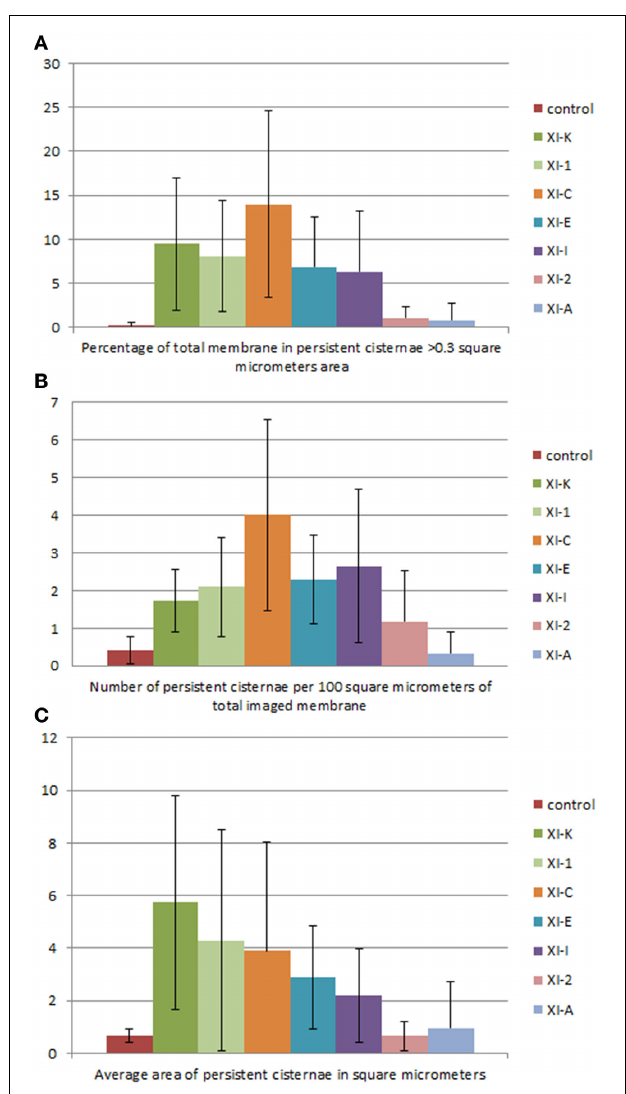
FIGURE 7 | Quantification of the effects of myosin tail domains on persistent ER cisternae. (A) Counts of the cumulative percentage area of highly persistent cisternae (see Figures 5 , 6 for examples). (B) Counts of the number of persistent cisternae per hundred square micrometers of ER membrane analyzed for all of the myosin subclasses. (C) Average area of persistent cisternae in square micrometers. Error bars represent standard deviation. The level of significance of the difference between the samples is described in Table 1 .